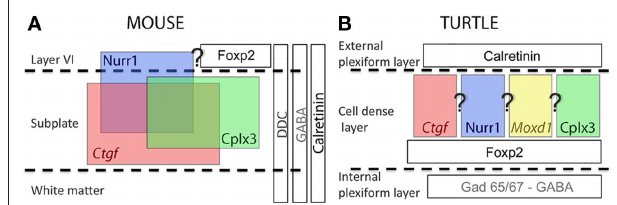
Figure 3 | Schematic diagram summarizes the distribution and overlap of several murine subplate cell markers and other neuronal markers in rodents and their distribution in turtle. (A) In early postnatal mouse cerebral cortex Cplx3 and Ctgf are exclusively expressed in subplate